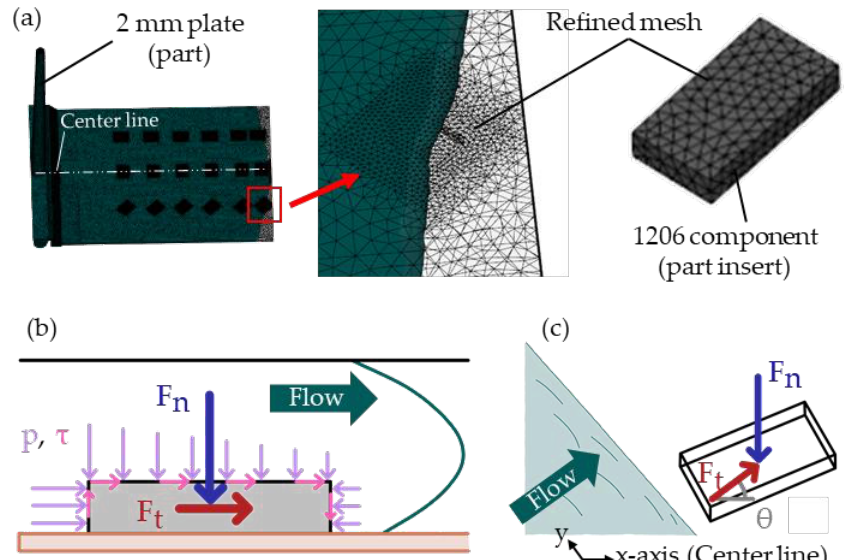
Figure 4. Filling illustration of the 2 mm plate AMI model ( a ). Pressures (p) and shear stresses ( τ ) accumulate into normal (F n ) and tangential (F t ) forces on the components during filling ( b ). A shear angle ( θ ) might be used to specify the direction of the tangential force (F t ) with respect to the center line ( c ).